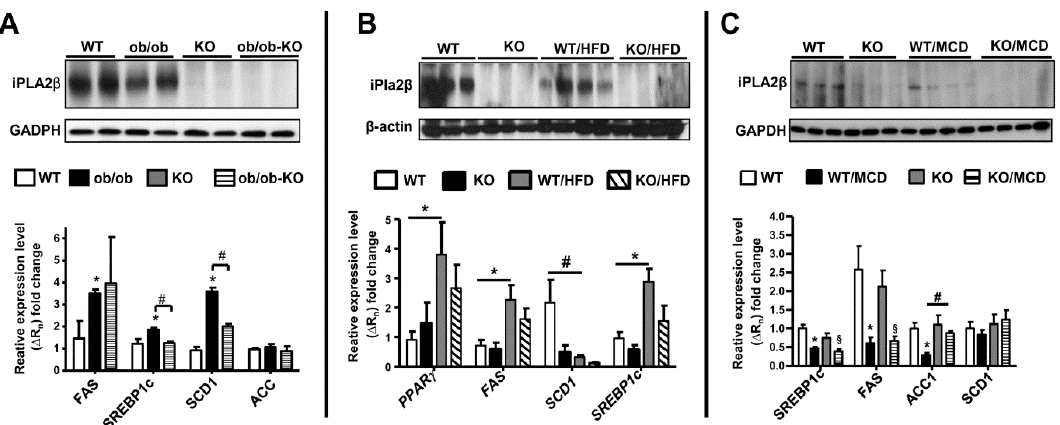
Figure 8. Expression of iPLA 2 β protein and de novo lipogenesis mRNA in livers of WT, Ob / Ob mice, HFD-, and MCD-fed mice. Ob / Ob mice, HFD-, and MCD-fed mice are described in Figures 1, 3 and 5, respectively. Expression of ( A ) iPLA 2 β protein, ( B ) HFD-fed mice, and ( C ) MCD-fed mice. Data are mean ± SEM, N = 5–7 for PCR data; #, p < 0.05; §, p < 0.05, KO versus KO / MCD; *, p < 0.05 between indicated groups.